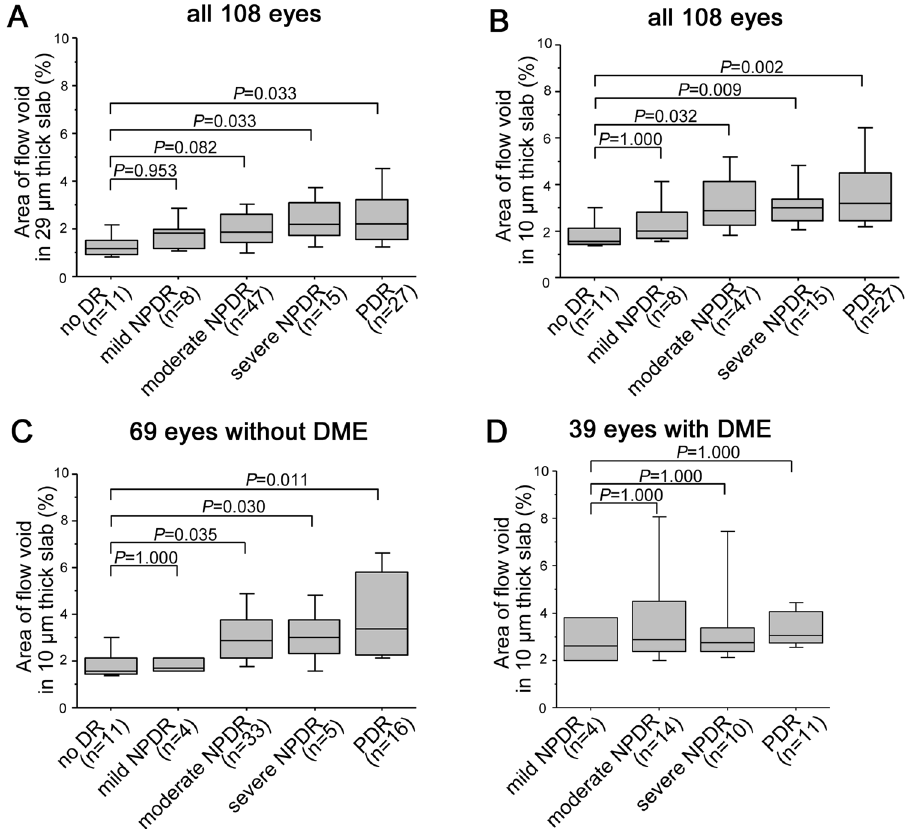
Figure 6. The areas of flow void in the choroid capillary OCTA slab in individual DR severity grades. The non- flow areas within the CSF in the 29- μ m-thick choroid capillary slab of the default setting ( A ) or the 10- μ m-thick choriocapillaris layer ( B ) increase gradually according to individual DR severity grades in all 108 eyes. Areas of flow void in the 10- μ m-thick choriocapillaris layer in eyes without ( C ) and with ( D ) center-involved